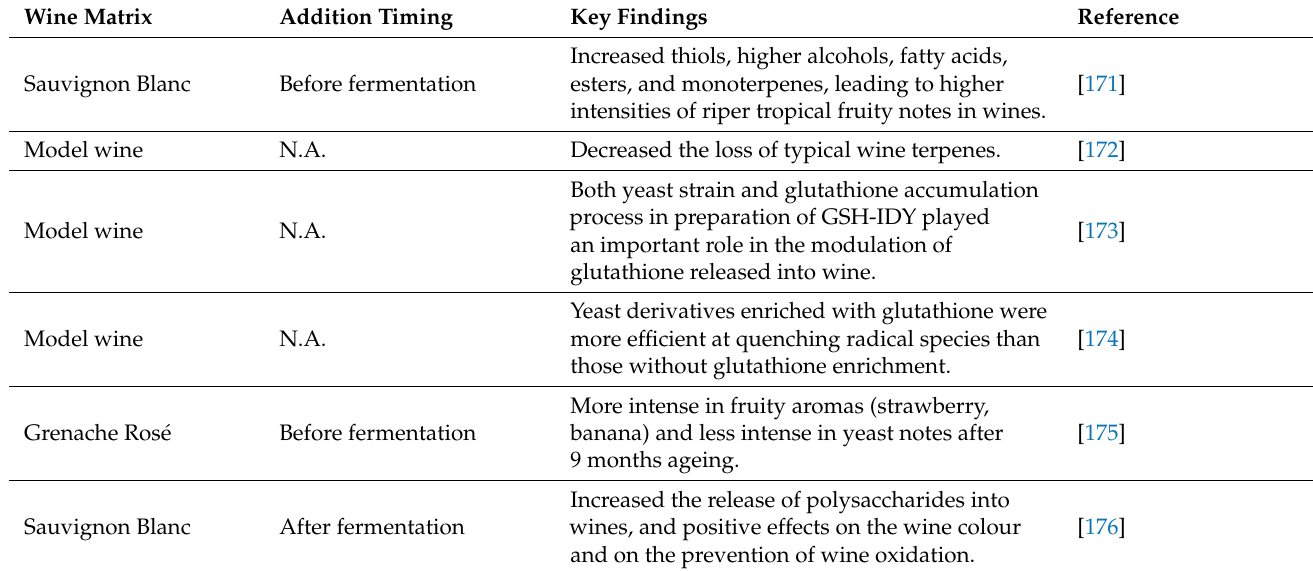
Table 3. Summary of previous studies on glutathione-enriched inactivated dry yeast